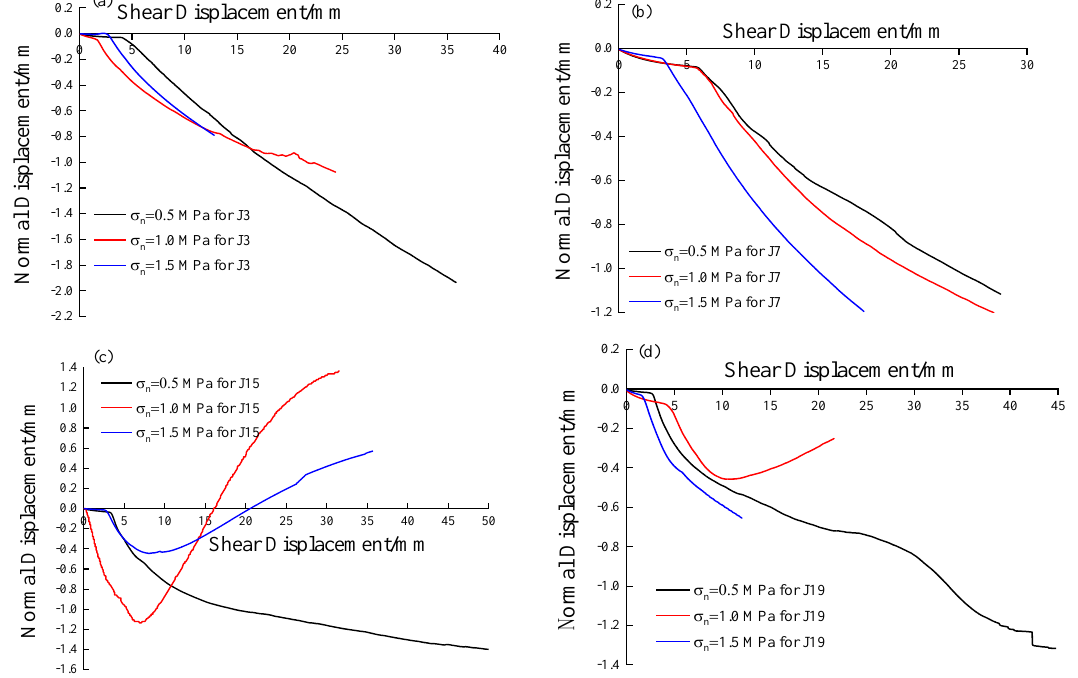
Fig.9. Normal displacement versus shear displacement curves of joints filling with plastic soil (30% MC).